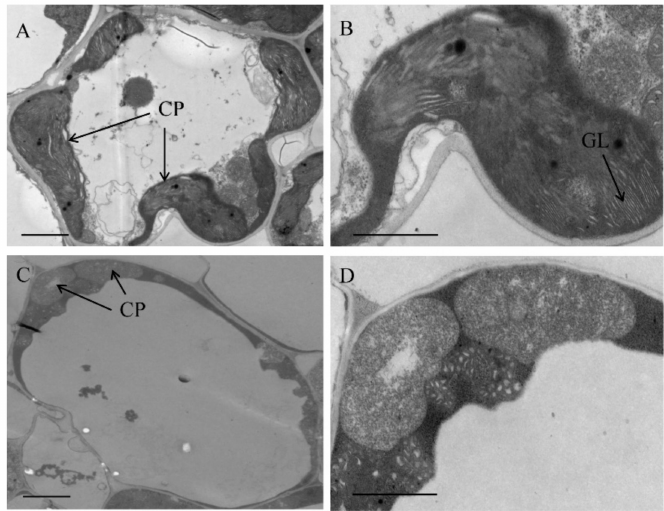
Figure 7. Chloroplast ultrastructure of WT ( A , B ) and oscfm2-1 mutants ( C , D ). cp, chloroplast, gl, grana lamella. Bars = 2.0 µ